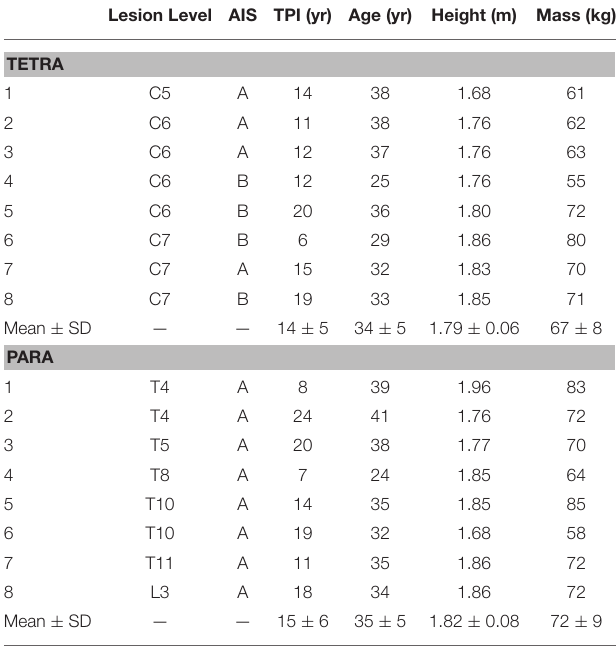
TABLE 1 | Participant